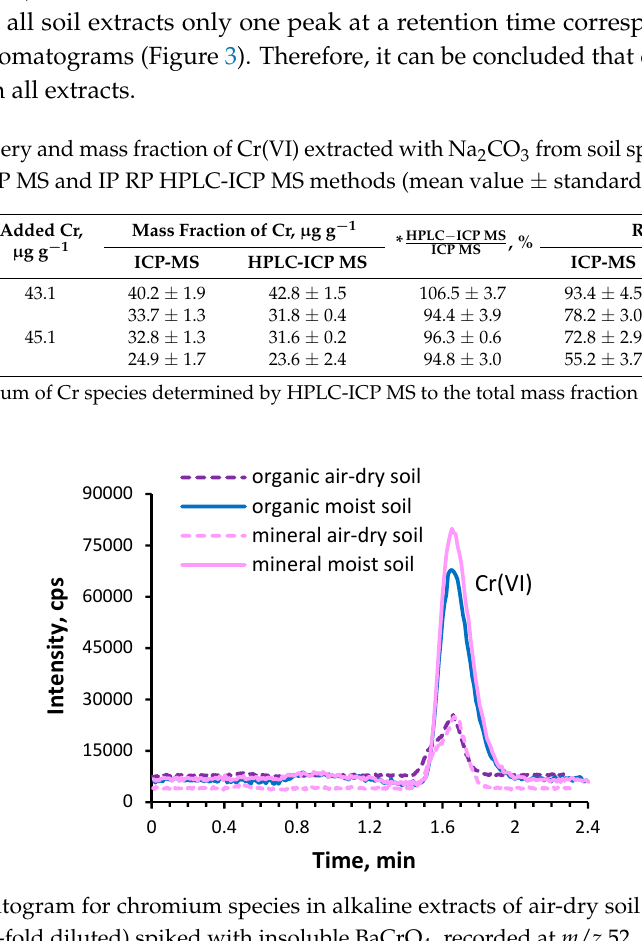
Table 5. The recovery and mass fraction of Cr(VI) extracted with Na 2 CO 3 from soil spiked with